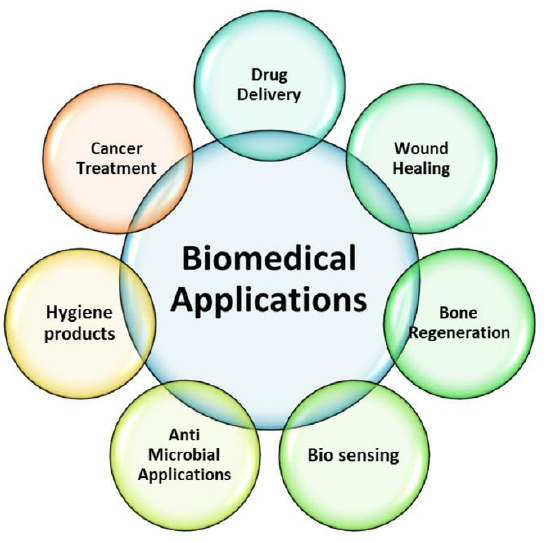
Figure 8. Schematic representation of biomedical applications of polymer gels [92]. A summary of different categories of polymer gels cross-linked by physical, chemical, or irradiation methods used in biomedical applications is presented in Table 2. Table 2. Applications of polymer gels cross-linked by physical, chemical or irradiation methods.